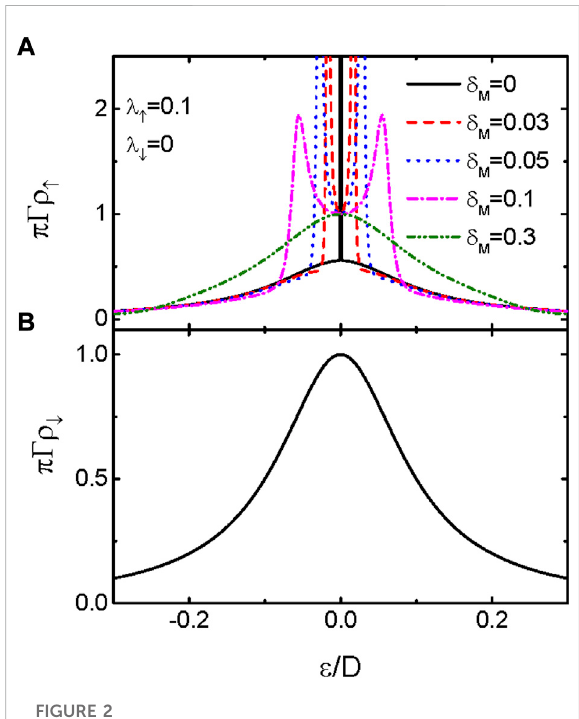
FIGURE 2 (Color online) (A) Spin-up and (B) spin-down LDOS as functions of the electron energy for fi xed λ ↑ = 0.1, λ ↓ = 0, and different values of δ M . The other parameters are as in Figure